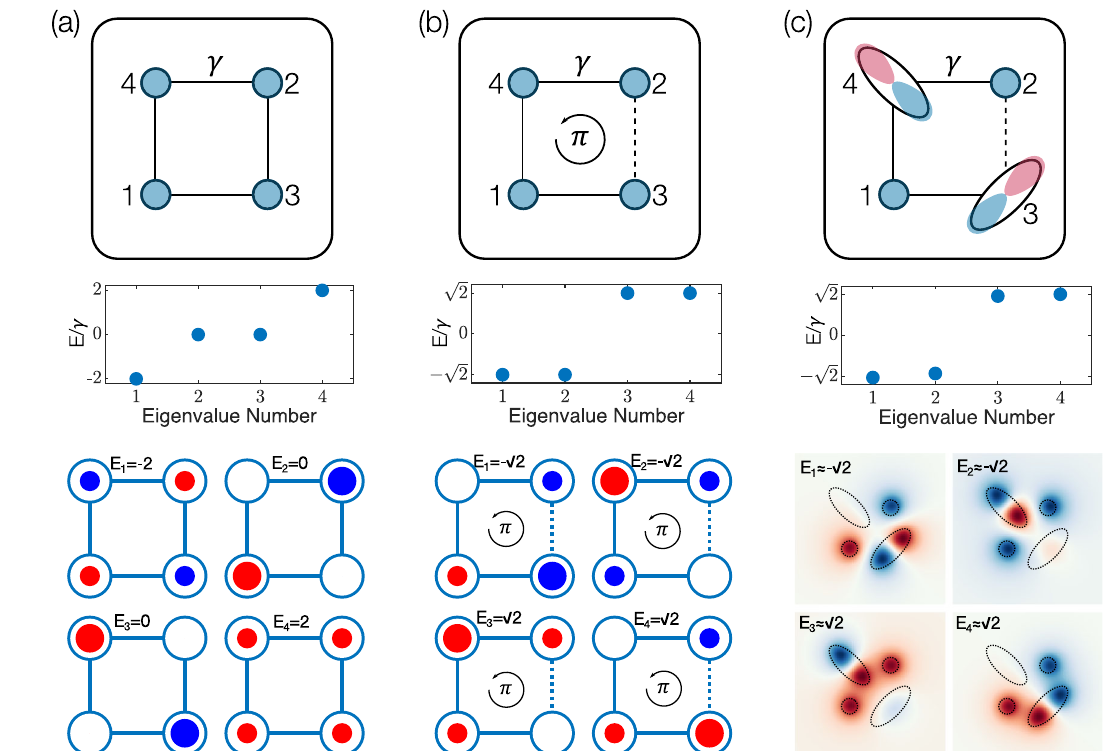
Fig. 1 | Synthetic π fl ux threading a unit cell plaquette induced by s and p orbitals. Schematic and corresponding eigenvalues and eigenmodes of a unit cell plaquette a composedofonly s orbitalswithoutsynthetic π fl ux, b withsynthetic π fl ux, and c composed of both s and p orbitals, respectively. The solid and dashed lines in the schematic indicate the positive and negative couplings, respectively. E denotes the eigenvalues and γ denotes the coupling rate between the